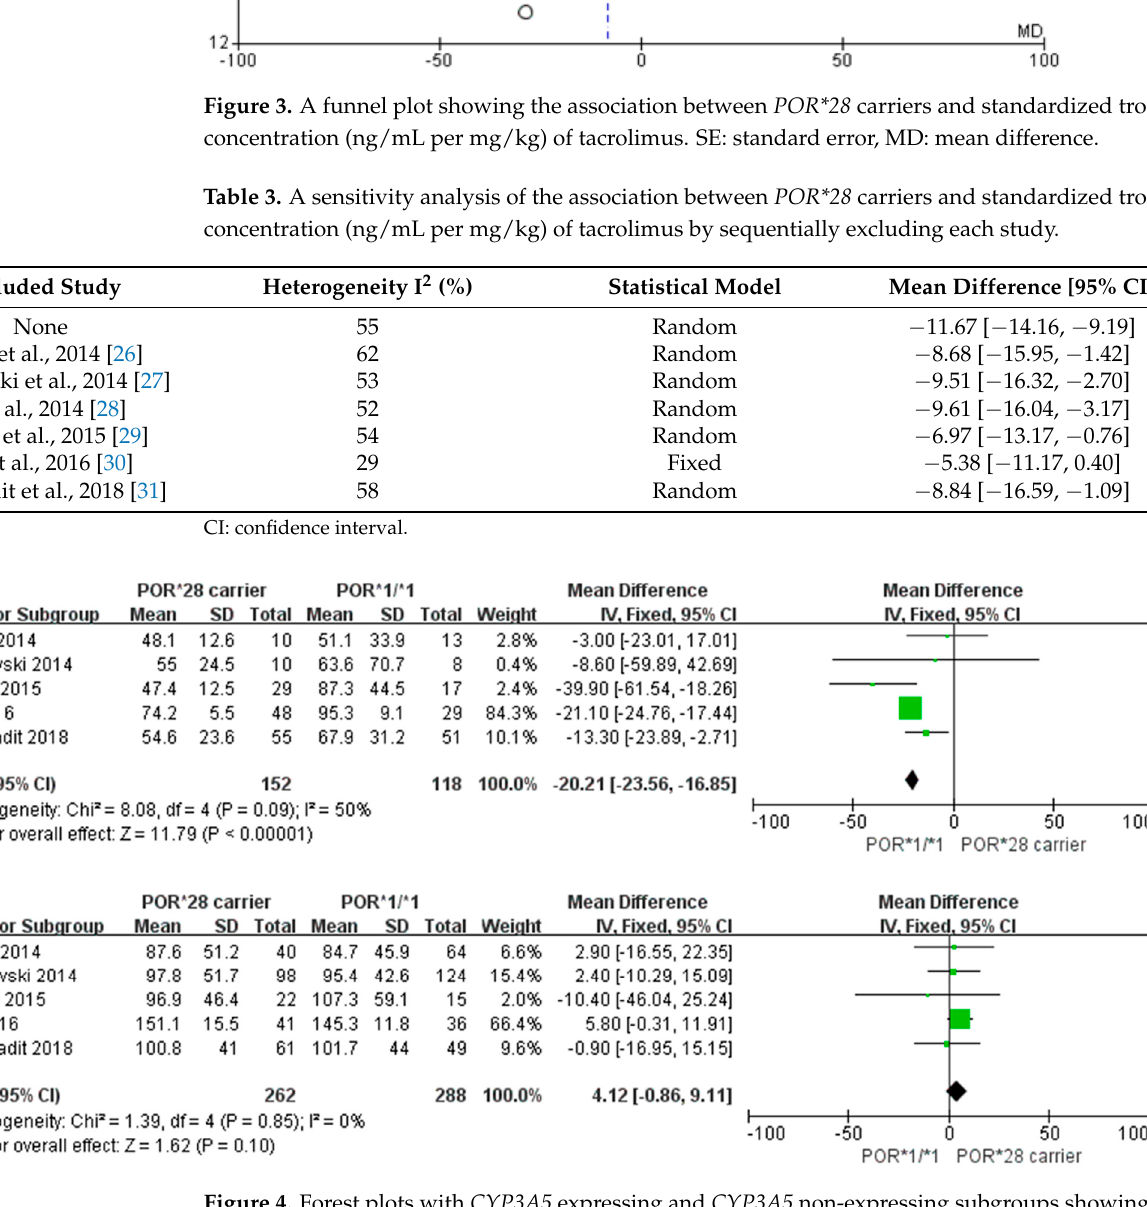
Figure 4. Forest plots with CYP3A5 expressing and CYP3A5 non-expressing subgroups showing the association between POR*28 carriers and standardized trough concentration (ng/mL per mg/kg) of tacrolimus. ( a ) CYP3A5 expressers; ( b ) CYP3A5